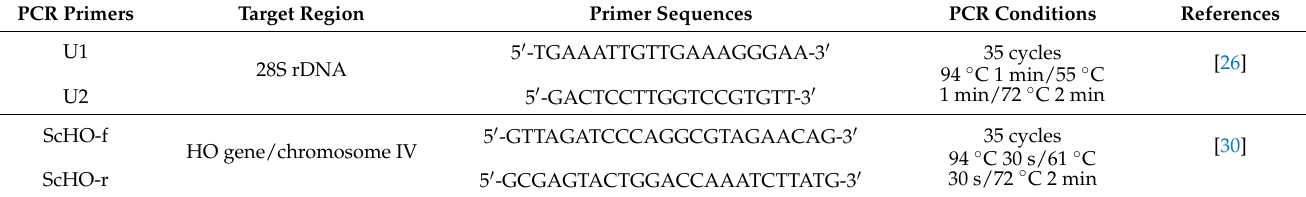
Table 1. List of primers used for yeasts identification and the respective PCR conditions. PCR Primers Target Region Primer Sequences PCR